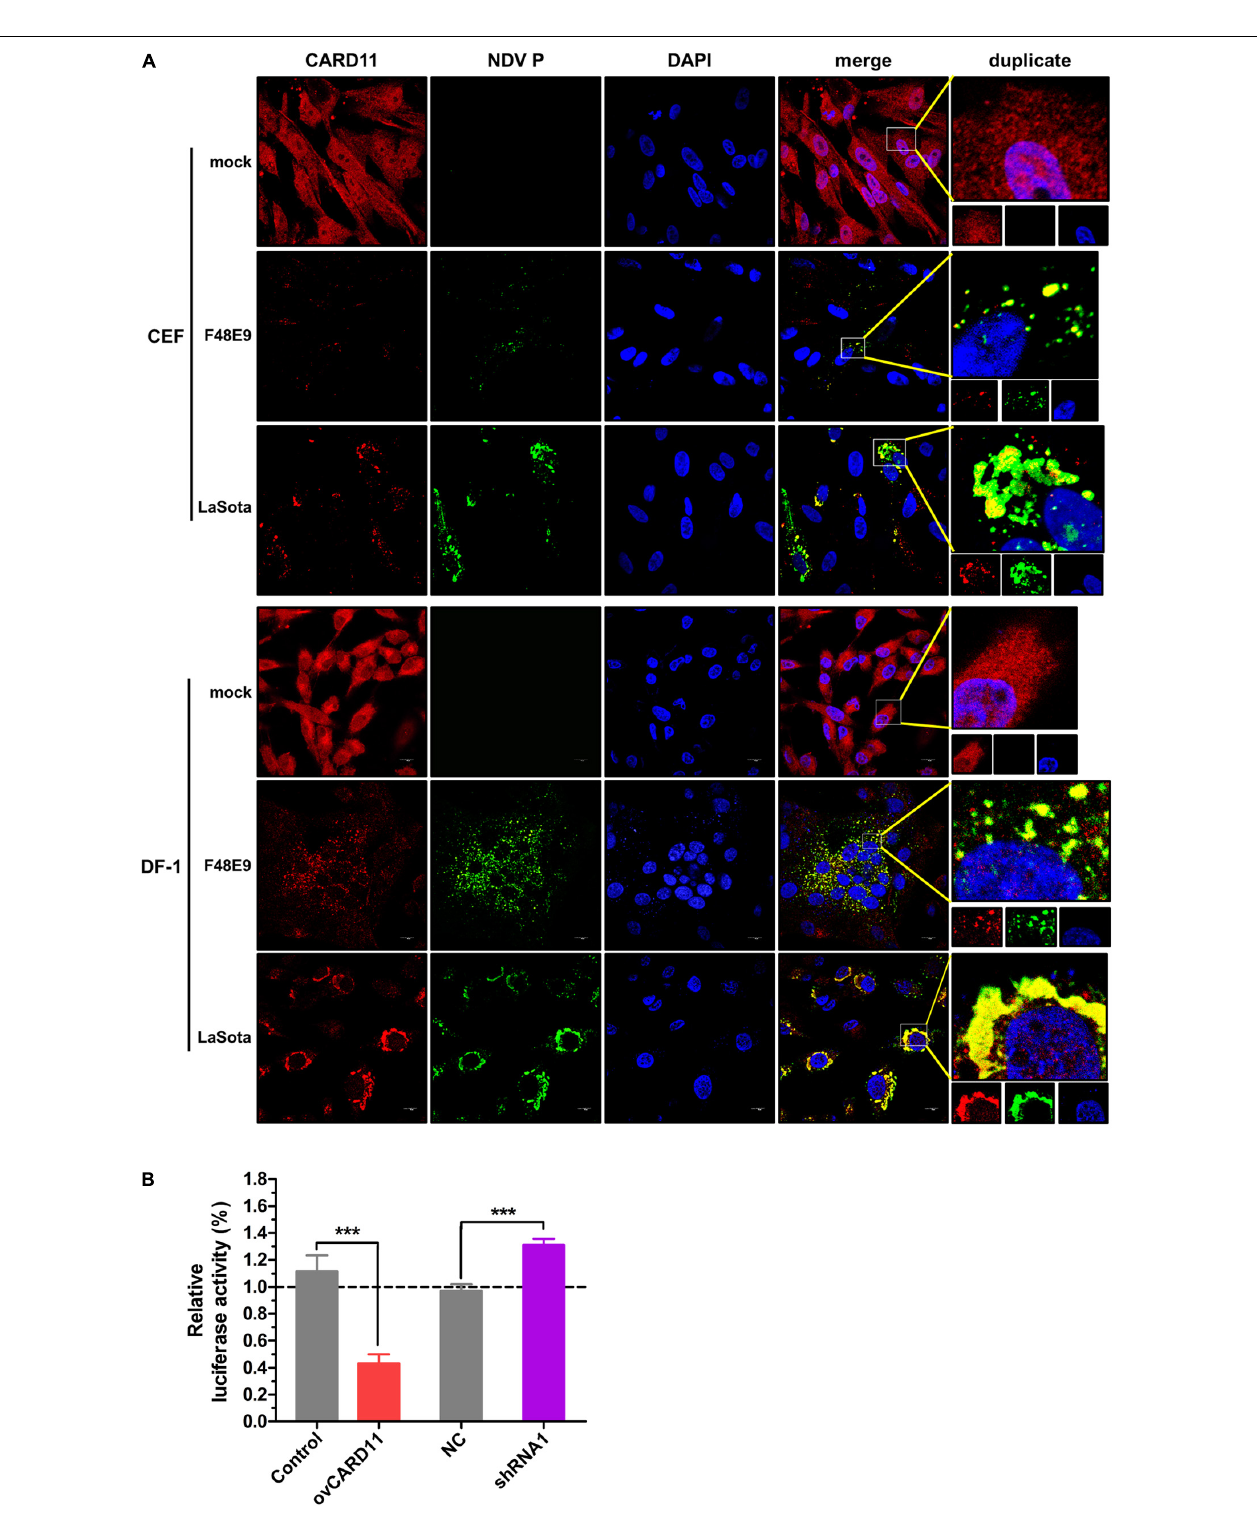
FIGURE 4 | Subcellular colocalization of CARD11 and the viral P protein in chicken fibroblasts. (A) CARD11 colocalized with the viral P protein in F48E9 (MOI = 0.01) and LaSota (MOI = 1)-infected CEFs and DF-1 cells. CARD11 (red), P protein (green), and the nucleus (blue) were observed by confocal microscopy. Scale bar = 10 µ m. (B) Inhibition of viral RNA polymerase activity by CARD11 overexpression using a three-plasmid system. The DF-1 cell lines were cotransfected with pCAGGS-T7, pCMV-NP-P-L, and MG-Fluc at a ratio of 2:1:1. All the cells above were cotransfected with pRL-SV40-N expressing Renilla luciferase as a normalizing standard and lysed at 36 h posttransfection. Representative data, shown as the mean ± SD ( n = 3), were analyzed by two-tailed Student’s t -test. *** p < 0.001.